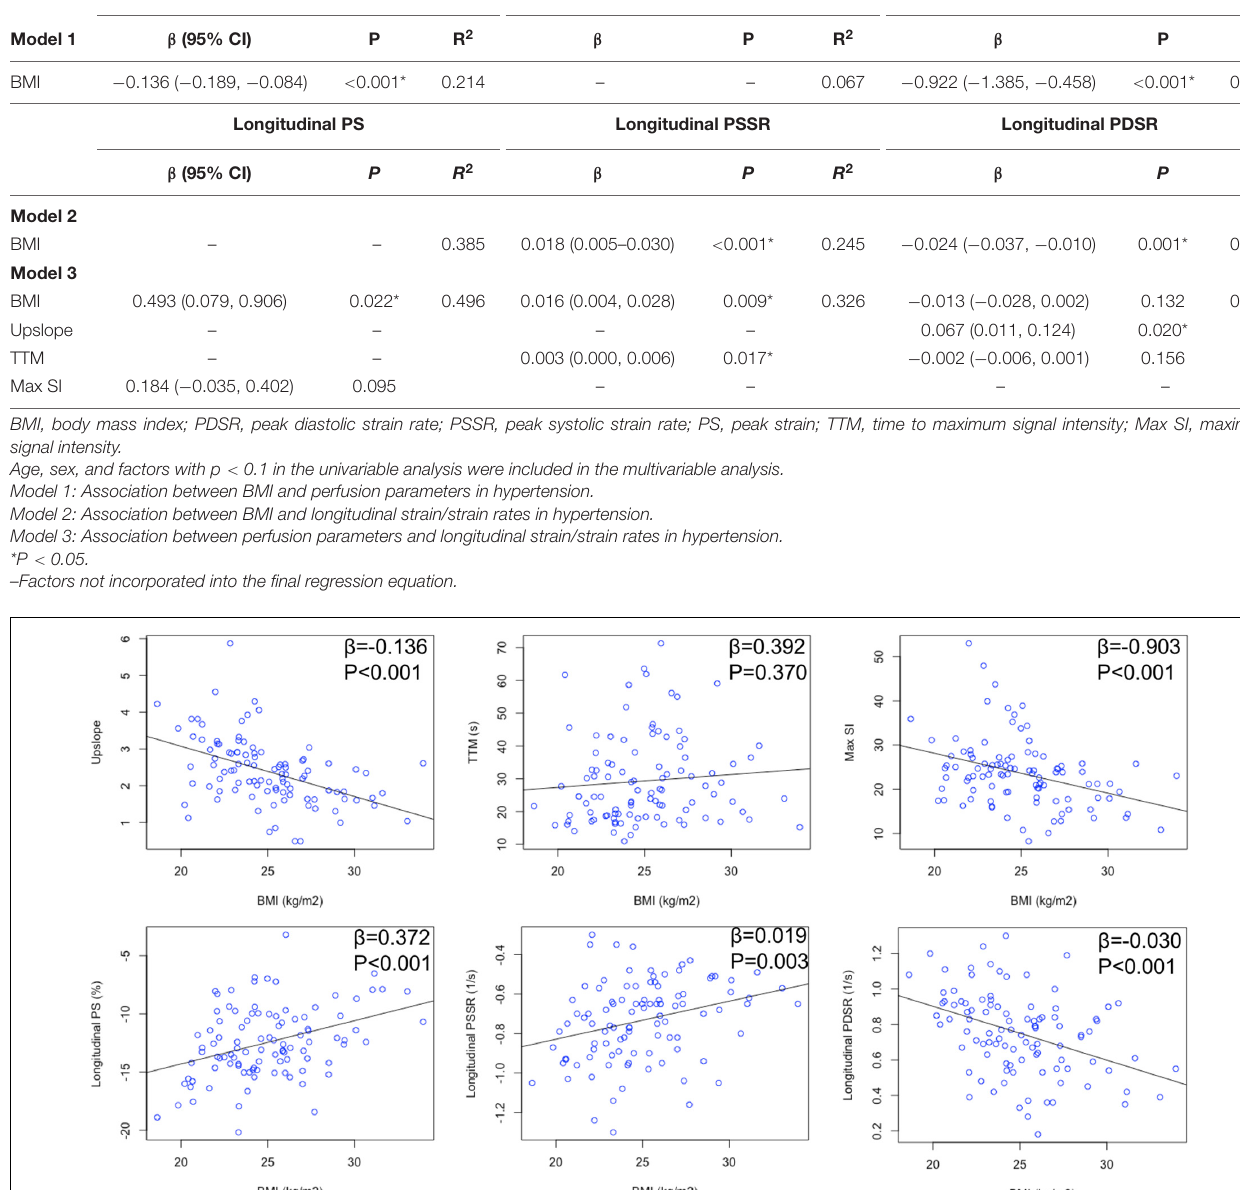
TABLE 3 | Multivariable linear regression analyses in hypertensive patients. Upslope TTM Max SI